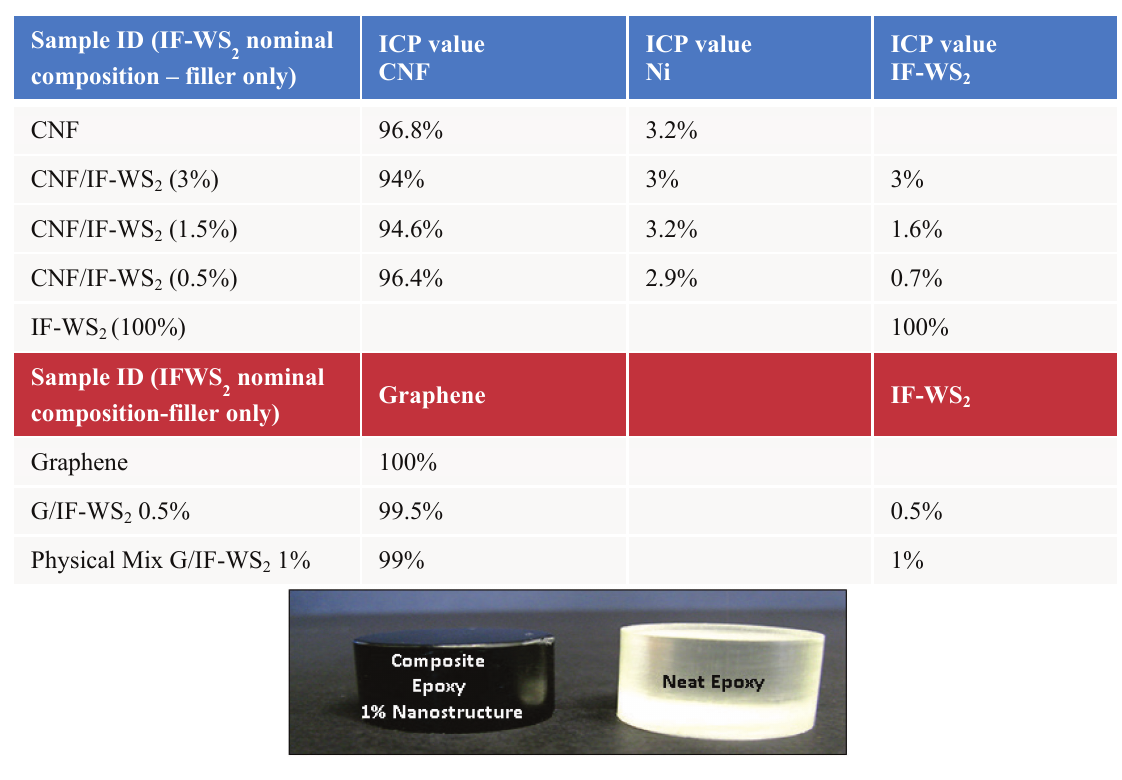
Table 1. Filler compositions used for epoxy composites (first